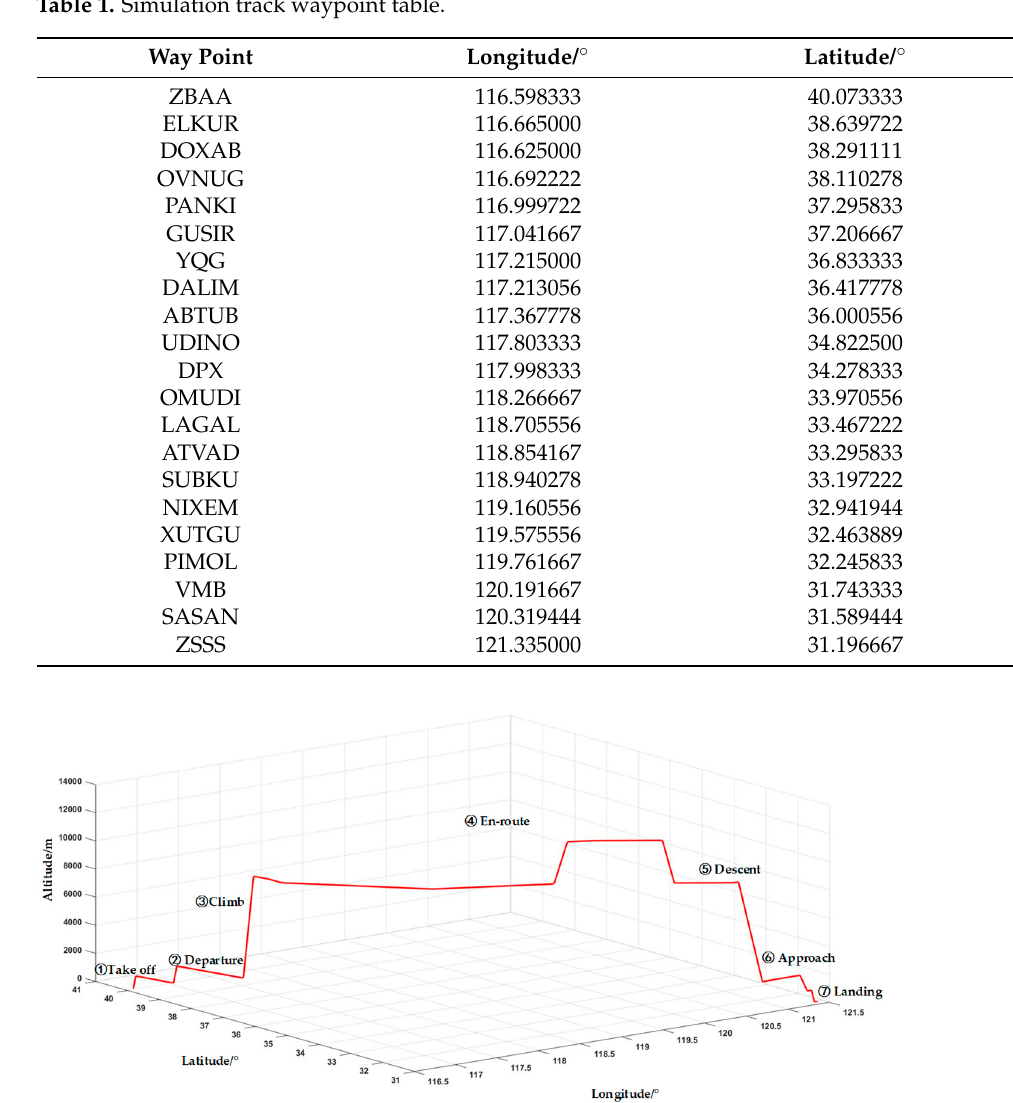
Table 1. Simulation track waypoint table.